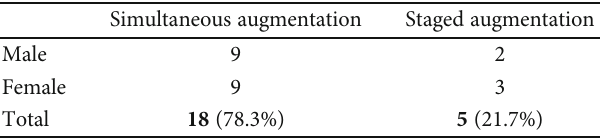
Figure 2: Simultaneous implant placement and horizontal augmentation in the anterior maxilla with delayed loading strategy. (a) Postextraction horizontal defect of 21 alveolar ridge, in which implant placement leaves two-thirds of the implant length exposed; (b) DBBM particle is applied to cover the implant and augment the alveolar defect; (c) at reentry six months after bone grafting, the augmented area is stable with still visible DBBM particles blended with the newly formed bone; (d) at prosthetic phase, the labial tissue width is shown to be comparable to the adjacent tissue; (e) fi nal restoration shows healthy labial and interdental peri-implant tissue. Table 1: The distribution of implant placement associated with simultaneous and staged augmentation